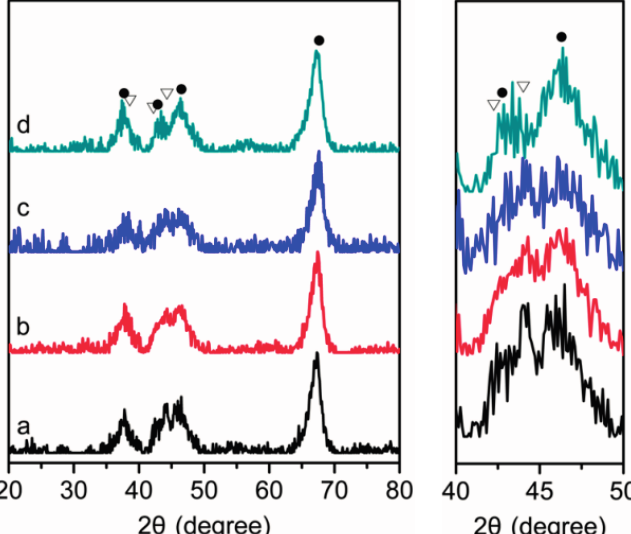
O ; ( b ) Ru-SnO 2 3 O ; ∇ ( ) Ru 0 2 3